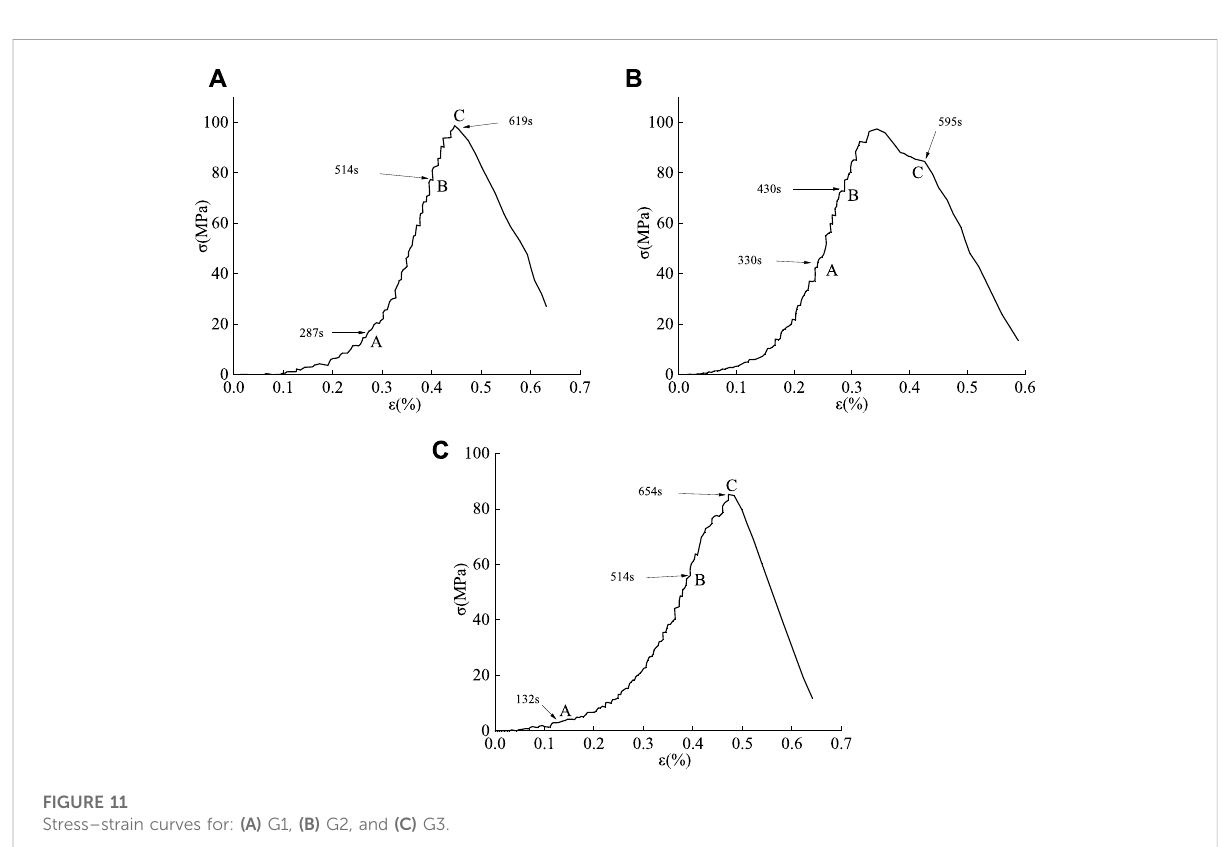
FIGURE 11 Stress – strain curves for: (A) G1, (B) G2, and (C)